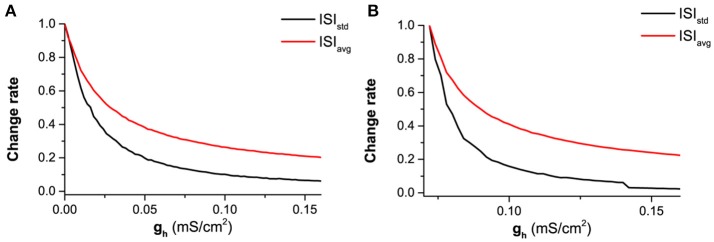
The decrease of normalized mean value (red) and standard deviation (black) of ISIs with increasing gh at different levels of Iapp and noise intensity D. (A)
Iapp = 0.17 μA/cm2 and D = 0.6μA/cm2; (B)
Iapp = −0.08 μA/cm2 and D = 0.2μA/cm2. ISIstd (black) and ISIavg (red) represent the standard deviation and mean value of ISIs.